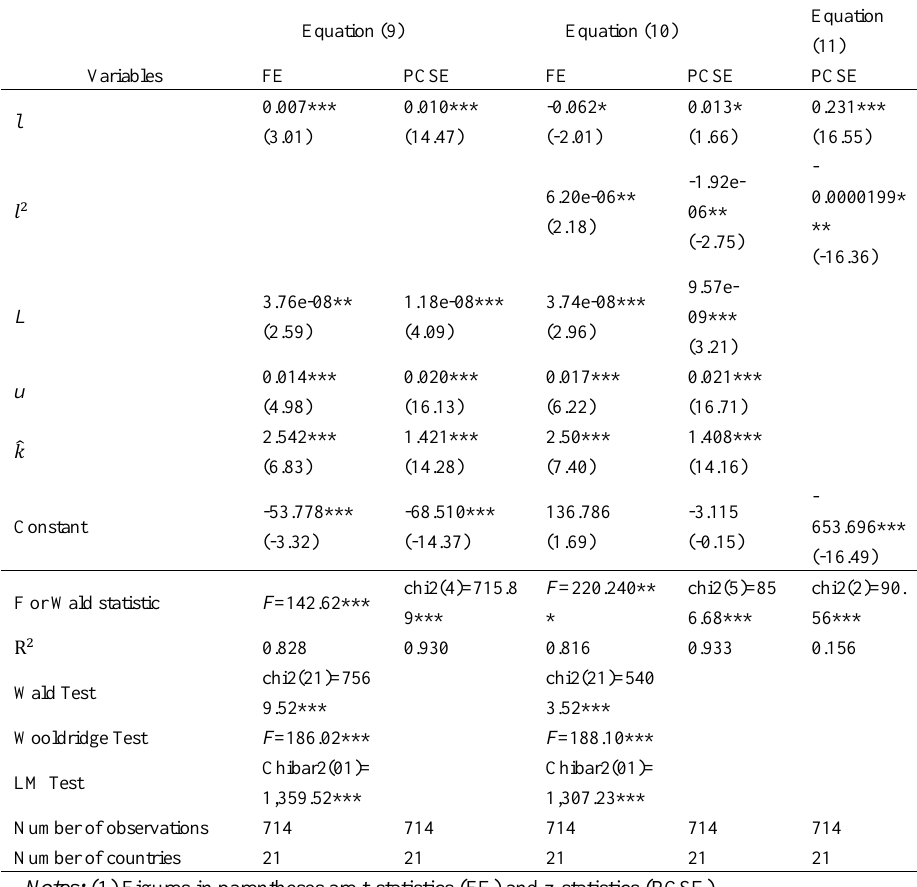
Table 3: Results of the panel data